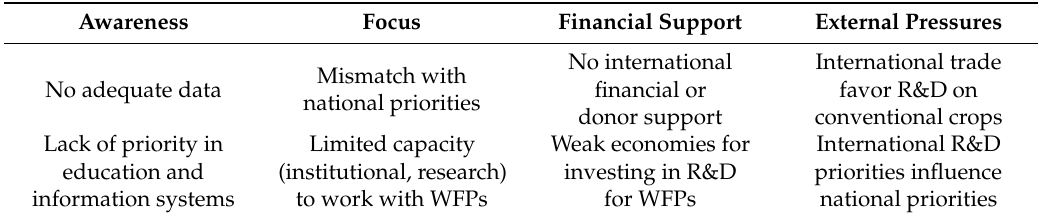
Table 2. Barriers that hinder the improvement of national policy frameworks towards supporting